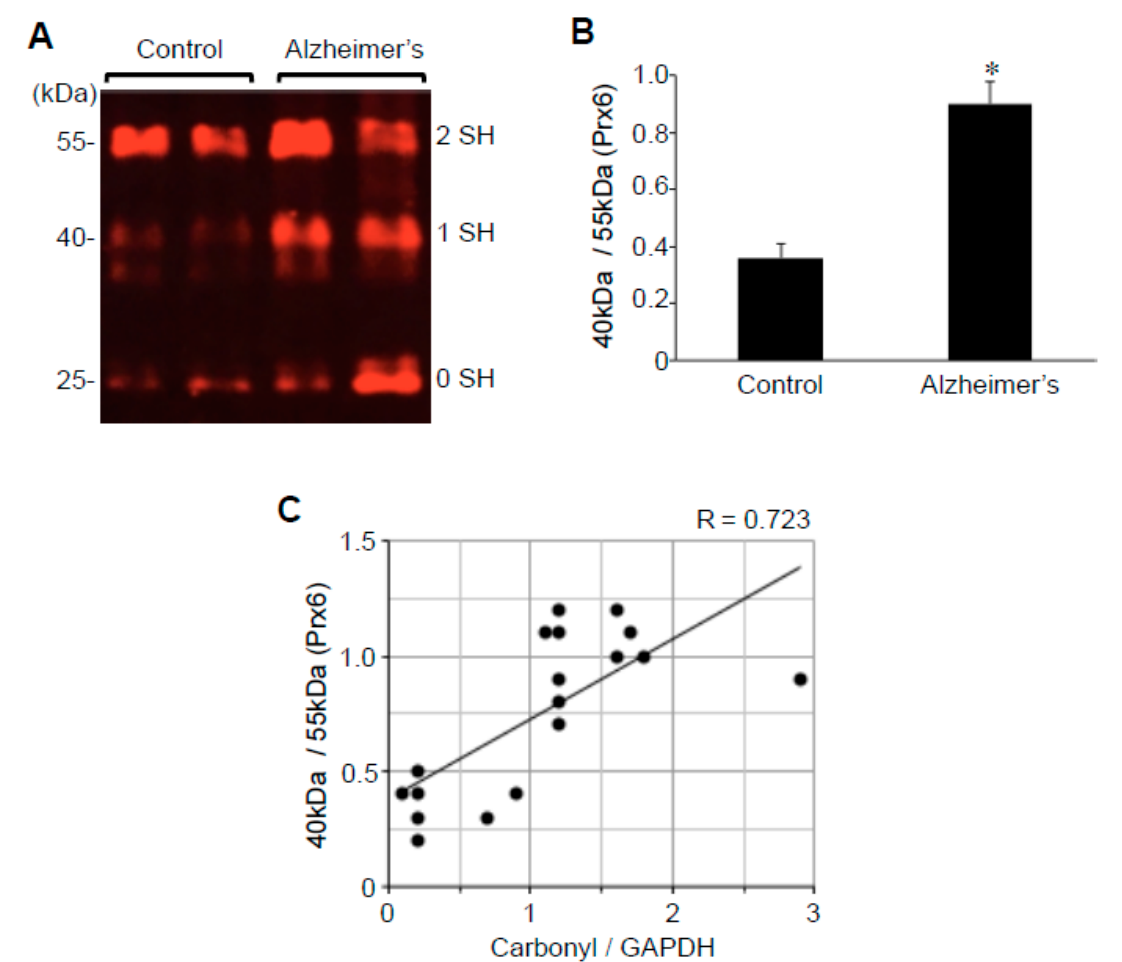
Figure 4. Cysteine oxidation of Prx6 is upregulated in the brains of patients with Alzheimer’s disease. Brain (hippocampus) homogenates from control subjects and patients with Alzheimer’s were investigated for cysteine oxidation of Prx6 using - SulfoBiotics - Protein Redox State Monitoring Kit Plus. A free protein thiol group was labeled with the Protein-SHifter Plus that contains maleimide with a high affinity toward reduced sulfhydryl groups. Each Protein-SHifter causes a 15 kDa shift. After electrophoresis, the Protein-SHifter Plus moiety was eliminated by exposure of the gel to ultraviolet light that increases the efficiency of Western blotting and allows for detection of specific proteins in biological samples. In the case of human Prx6, the protein with fully oxidized cysteine residues migrates at 25 kDa. The protein with one reduced cysteine binds to a Protein-SHifter and migrates at 40 kDa, and the protein with two reduced cysteine residues migrates at 55 kDa. Our previous study determined that the 40 kDa band depicts Prx6, in which the catalytic cysteine (Cys47) is oxidized [31]. ( A ) Representative Western blotting results using the Prx6 antibody showing 25 kDa (0 reduced sulfhydryl), 40 kDa (1 reduced sulfhydryl), and 55 kDa (2 reduced sulfhydryl) bands. ( B ) The bar graph represents means ± SEM of the ratio of the 40 kDa Prx6 band to 55 kDa Prx6 band (N = 13 for Alzheimer’s and 5 for control). The symbol * denotes that the value is significantly different from the control value at p < 0.05. ( C ) The scattered graph represents protein carbonylation vs. Prx6 thiol oxidation (N = 18). Pearson correlation coefficient R = 0.723 (positive correlation).